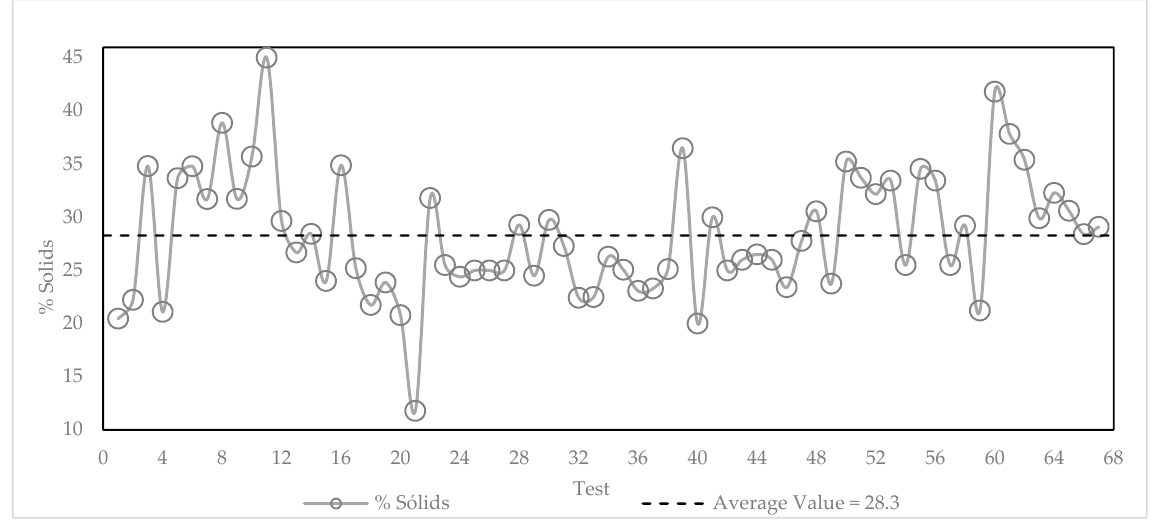
Figure 10. Variation of values concerning the percentage of solids in the flotation feed during the pilot